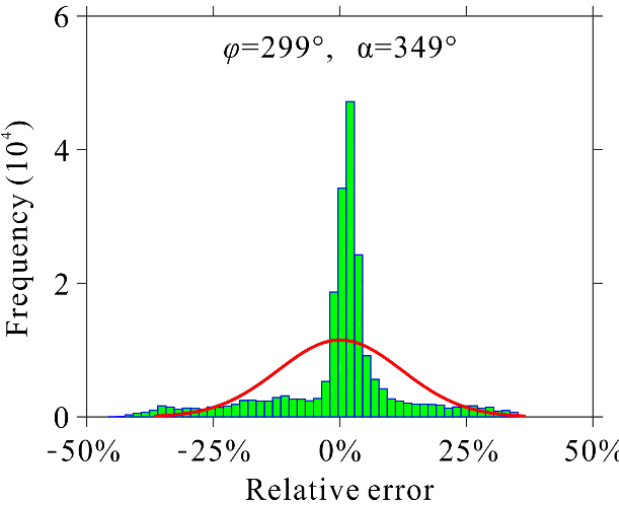
Figure 6. Histogram of the assessed relative errors of the NOV-estimated mining subsidence in the Qianyingzi coal mining area (see Figure 1d). The red line denotes the fitted frequency of the normal distribution.